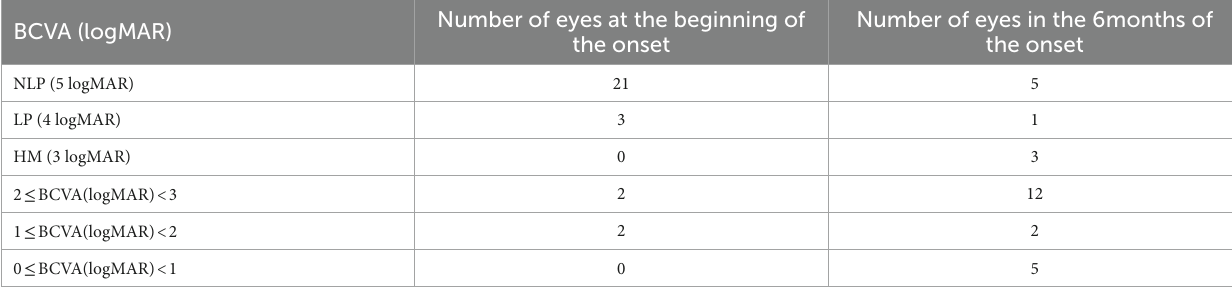
TABLE 2 The visual acuity in 14 cases (28 eyes) in the initial stage and 6 months after the onset.